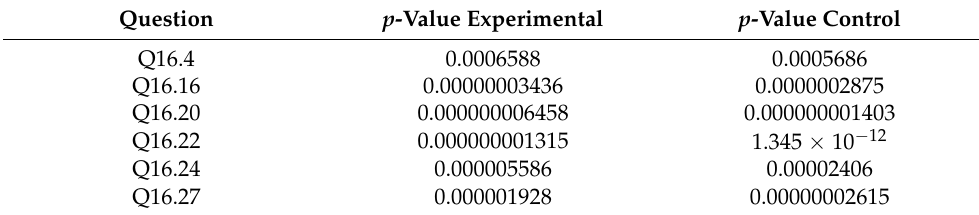
Table 3. Shapiro–Wilk test between experimental and control